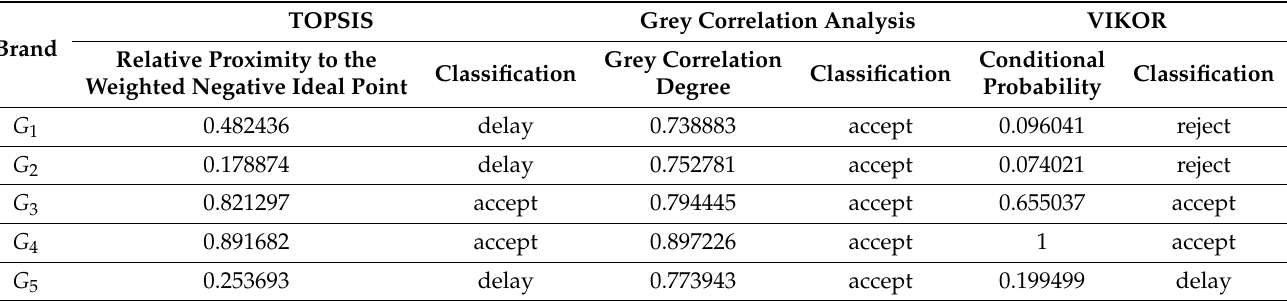
Table 14. The results under TOPSIS, grey correlation analysis and VIKOR